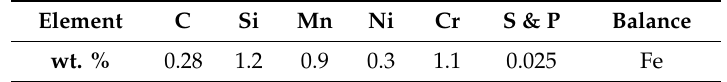
Table 1. The elemental composition of the high strength low alloy (HSLA) steel sheet.